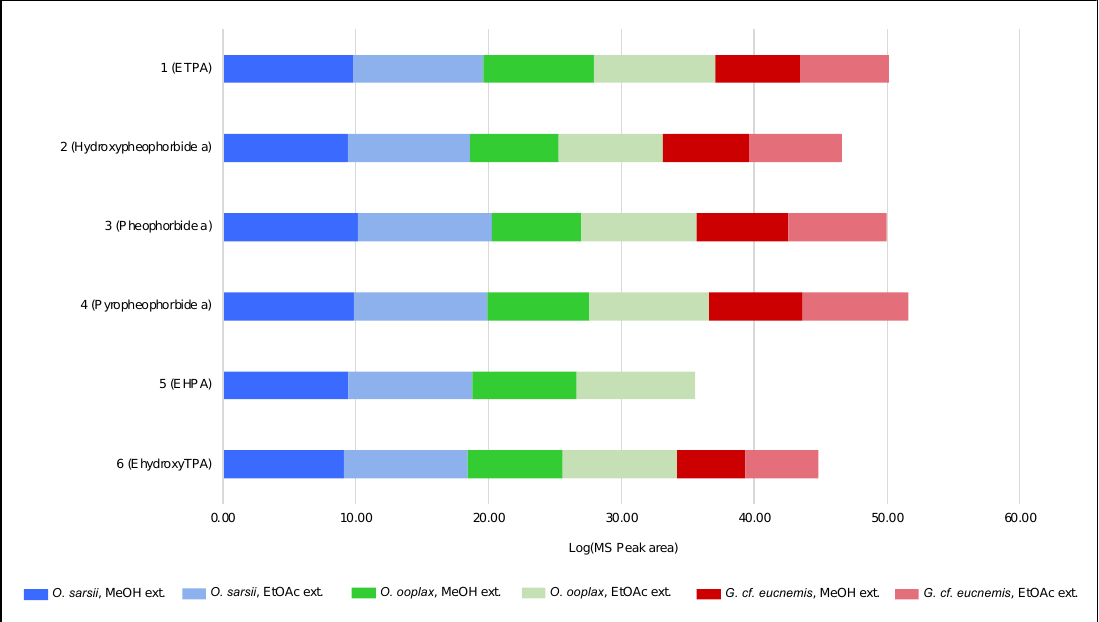
Figure 7. Log 10 of the MS peak area (from UHPLC-HRMS/MS analysis) of the 6 isolated chlorins in the EtOAc and MeOH extracts of Ophiura sarsii, Ophiura ooplax, and Gorgonocephalus cf. eucnemis .